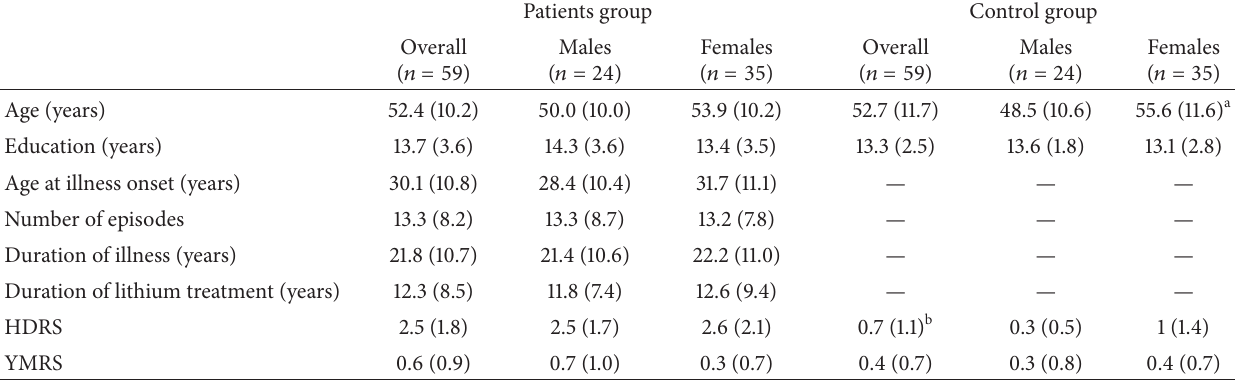
Table 1: Sociodemographic and clinical characteristics (values expressed as means and standard deviations shown in